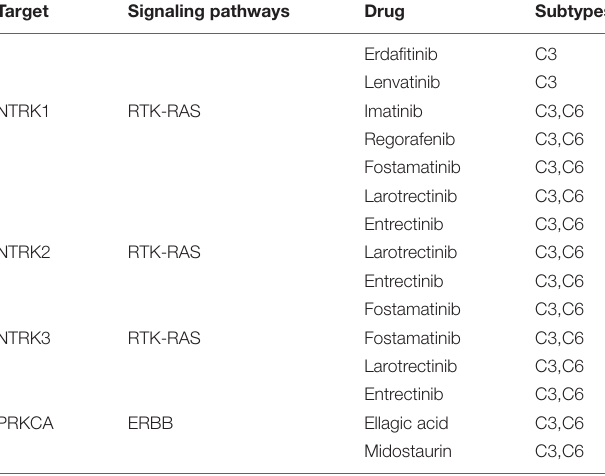
TABLE 1 | Therapeutic drugs corresponding to target genes in signaling pathways and which immune subtypes are